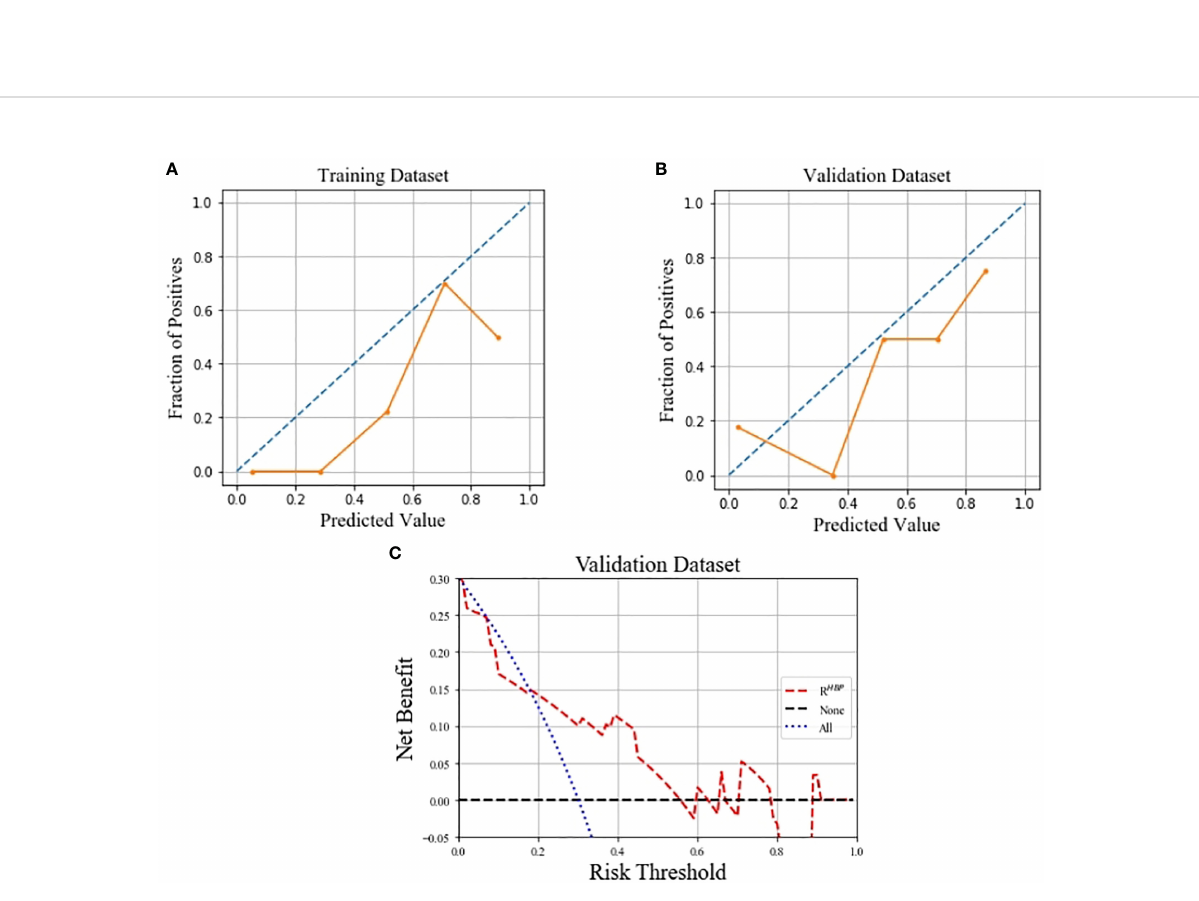
FIGURE 5 Calibration curves of the R HBP radiomics model in predicting b -catenin mutation on the training (A) and validation (B) dataset, which demonstrated good agreement with the ideal curve. Decision curve analysis for the R HBP radiomics model in the validation dataset (C)